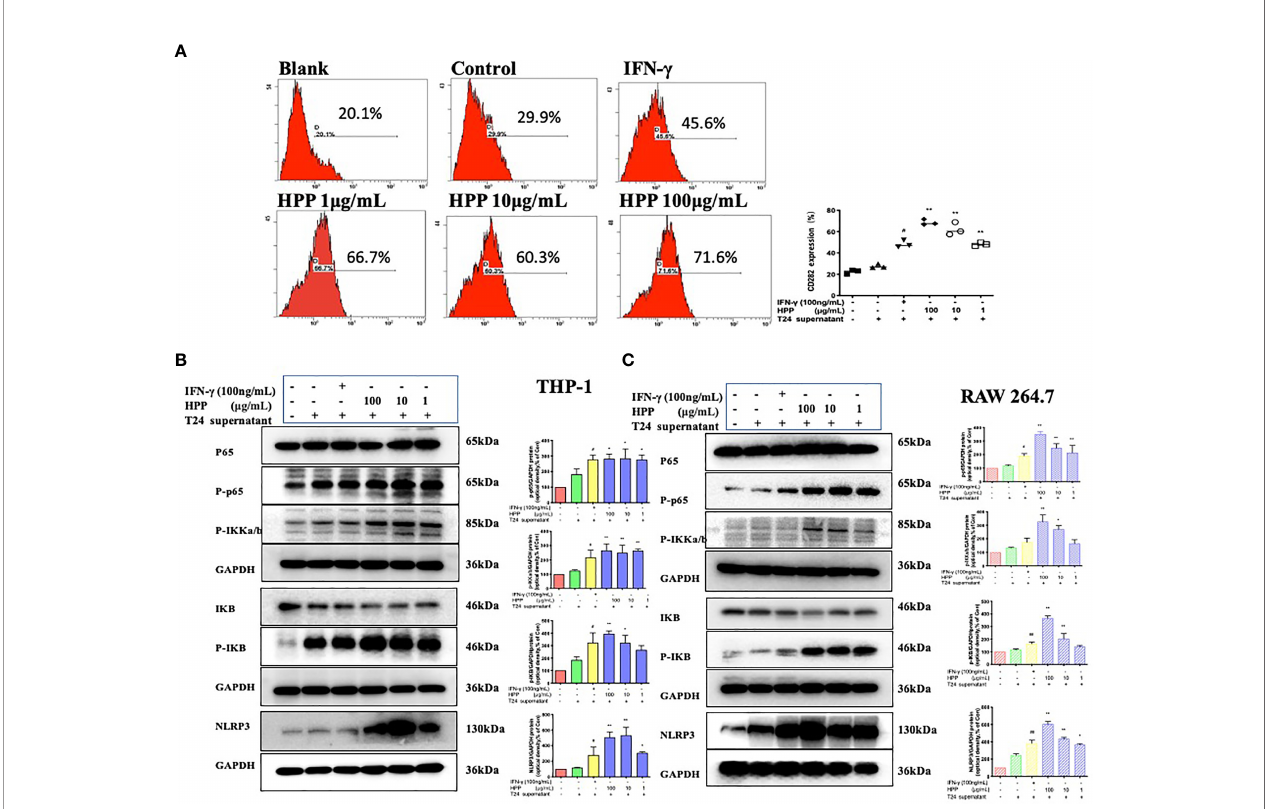
FIGURE 6 | Effect of HPP on the NF- k B/NLRP3 pathway in macrophages. (A) The expression of CD282 (TLR2) in macrophages treated with HPP for 24 h. Cells were collected and processed for the analysis of the cell cycle distribution by fl ow cytometry. (B) Effect of HPP on NF- k B/NLRP3 pathway in THP-1 macrophages. And p-I k B, p-IKK- a / b , p-P65 and NLRP3 were determined by western blot. (C) Effect of HPP on NF- k B/NLRP3 pathway in RAW 264.7 macrophages. And p-I k B, p-IKK- a / b , p-P65 and NLRP3 were determined using western blotting. Values are given as the mean ± SD from three independent experiments. Compared with the control group, # P < 0.05, and ## P < 0.01; compared with the RAW 264.7+T24 control group, * P < 0.05 and ** P <